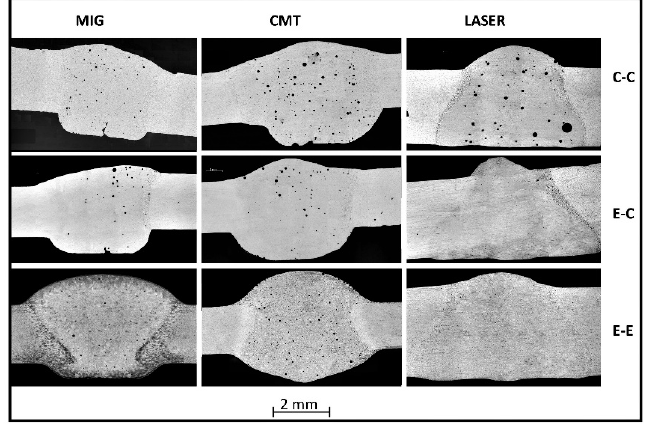
Figure 5. Weld geometry and defects of MIG, CMT (cold metal transfer), and fiber laser-MIG hybrid joints.